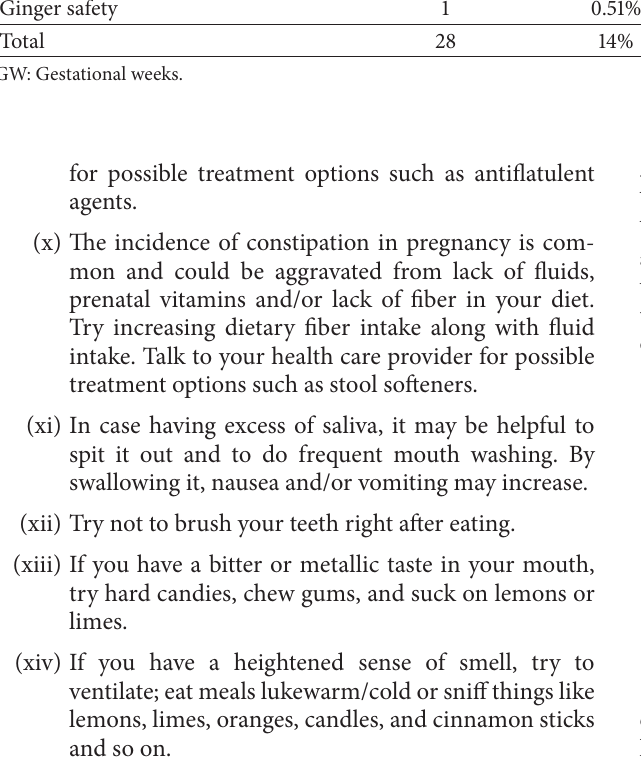
Table 5: Breakdown of the 28 women calling for safety information on drugs used for controlling nausea or vomiting. Reason for initial call 𝑛 % GA (GW ± St. Dev.) GA range (GW) Unisom + vit B6 info 12 6.15% Zofran and Unisom + vit B6 5 2.50% Unisom info 3 1.54% Promethazine 2 1.03% Unisom info + vit B6 and acid 1 0.51% 1 0.51% Unisom and insomnia 1 0.51% Breastfeeding and Unisom + vit B6 1 0.51% Breastfeeding and vit B6 1 0.51% Ginger safety 1 0.51% Total 28